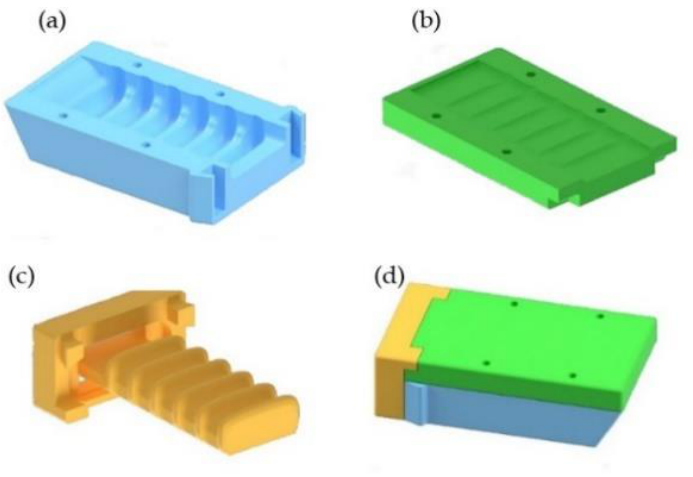
Figure 3. Mold for manufacturing silicone fingers: ( a ) Mold for inner side, ( b ) Mold for outer side, ( c ) Male mold, ( d ) The assembled mold.